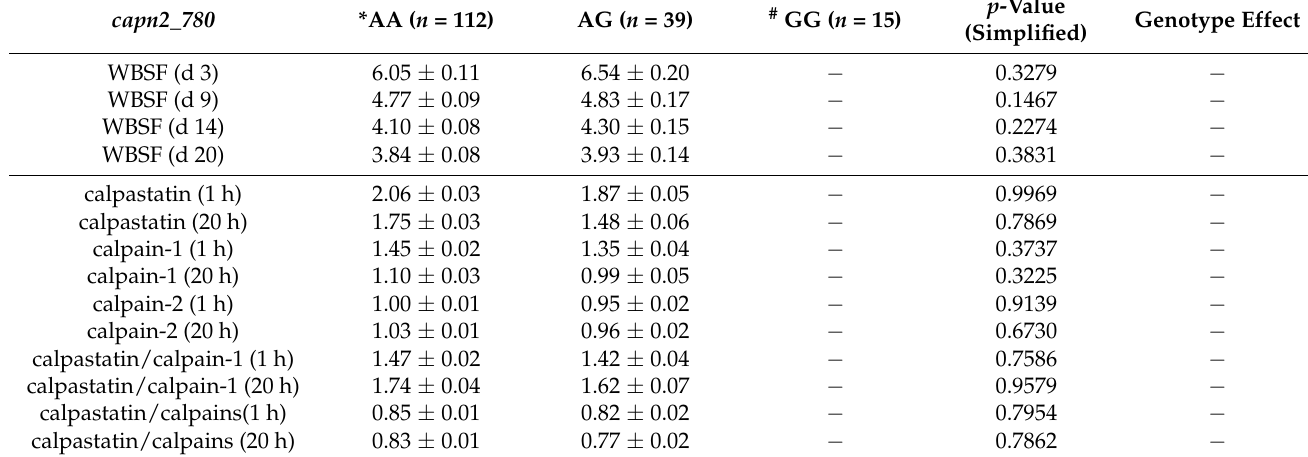
Table 4. The effects of genotype of the capn2_780 SNP on the tenderness phenotype, Warner–Bratzler shear force (WBSF) of representative purebred South African beef bulls during three to 20 days of ageing and on the muscle protease enzyme system during the first 20 h